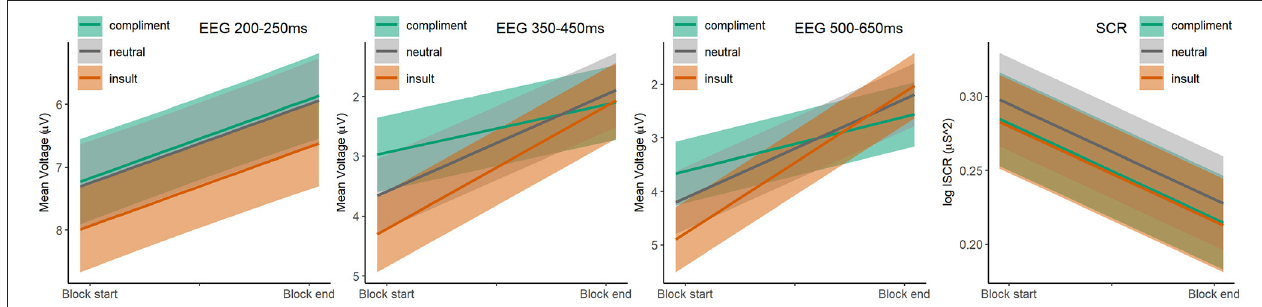
FIGURE 3 | Model estimates of Speech Act by Block interaction. Mean amplitude ERP estimated marginal means and 95% confidence intervals for the Speech Act * Block interaction for each of the three ERP latency ranges of interest ( µ V, three left panels, with more negative voltage up so that these panels fit with the ERP waveform panels in Figures 2 , 4 ), and the estimated marginal means and 95% confidence intervals for the Speech Act * Block interaction of the whole-trial skin conductance response (log ISCR 2 , right panel). All estimates based on the final model.